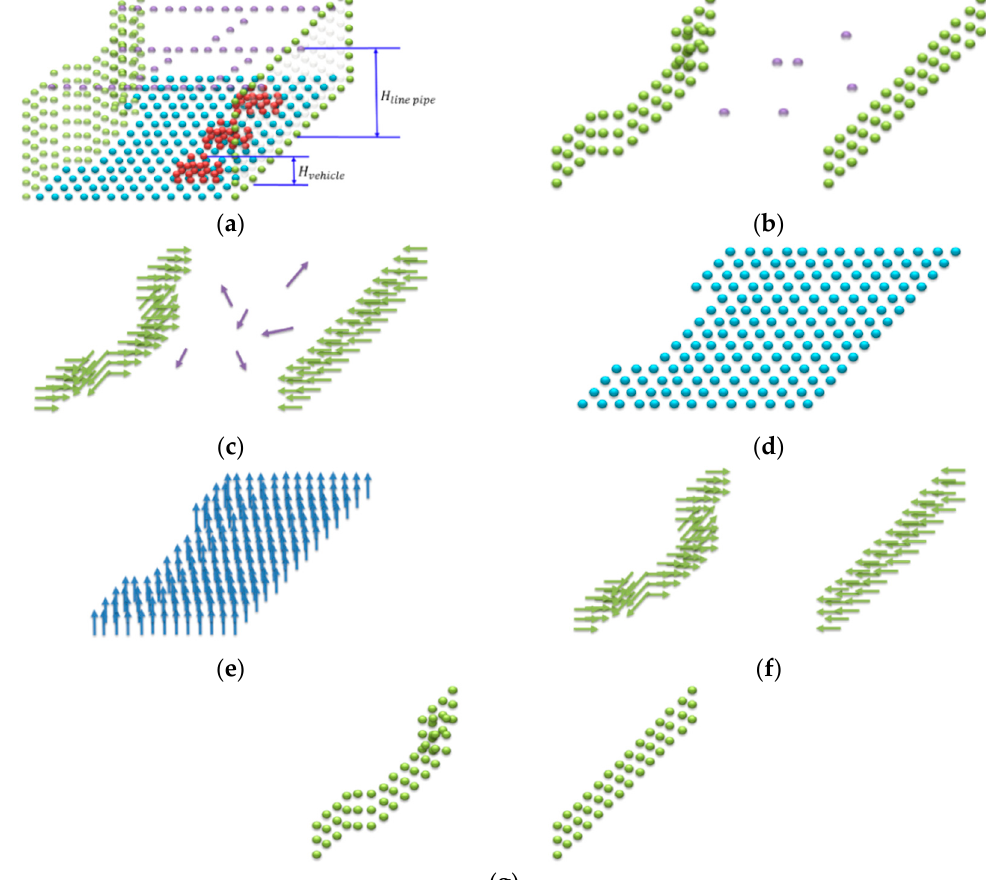
Figure 3. Segmentation of the 3D point cloud and its inner product. ( a ) Original point cloud information. ( b ) Point cloud information between H vehicle and H line pipe . ( c ) Vector information of the segmented point cloud. ( d ) Point cloud information of the road. ( e ) Vector information of the road. ( f ) Vector information of the inner product. ( g ) Point cloud information of the inner product.